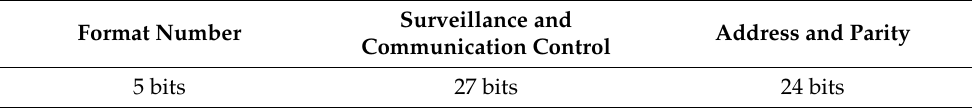
Table 1. Mode S Data Block Surveillance Interrogation and Reply Message Format [29].